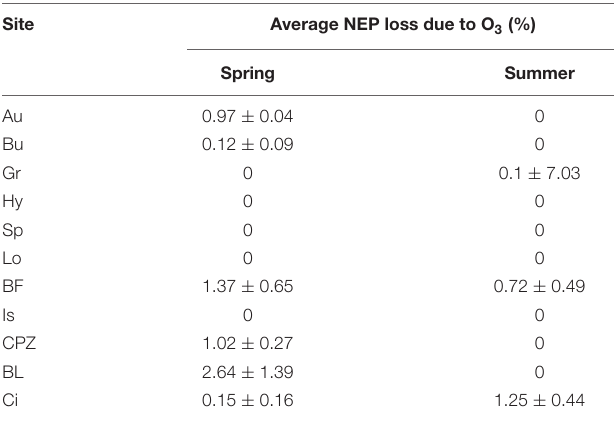
TABLE 5 | Average NEP loss due to O 3 in Spring and Summer seasons. Explanation of acronyms of the site names can be found in Table 1